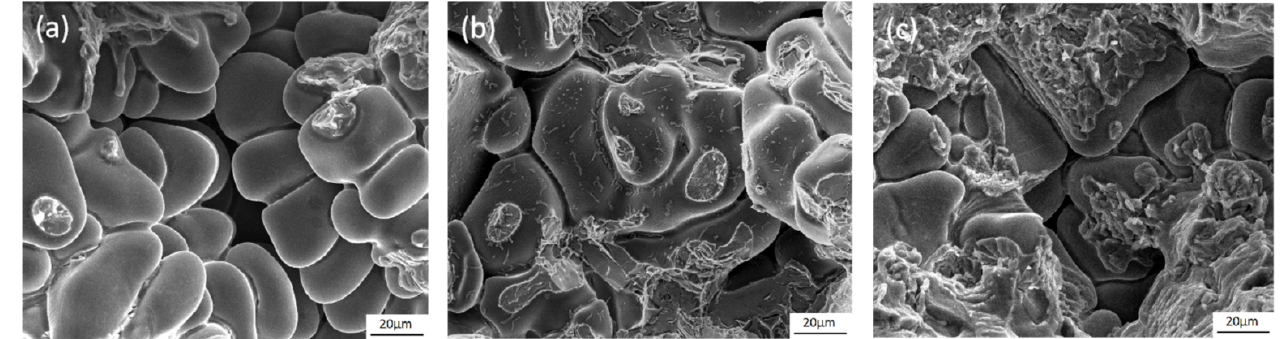
Figure 11. Intergranular morphology of ( a ) Al-Cu, ( b ) Al-Cu-La, ( c ) Al-Cu-La-Sc